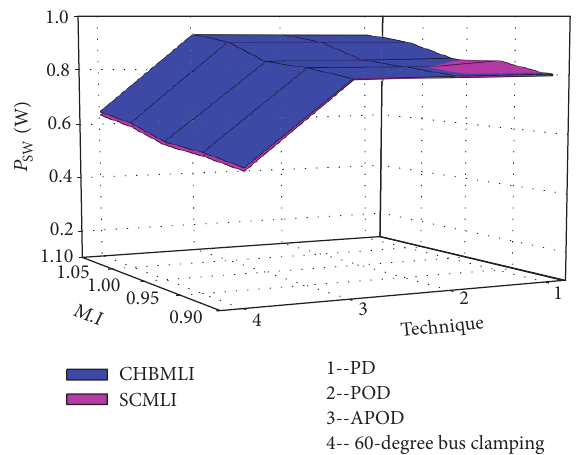
Figure 17: Switching losses comparison at various modulation indices.